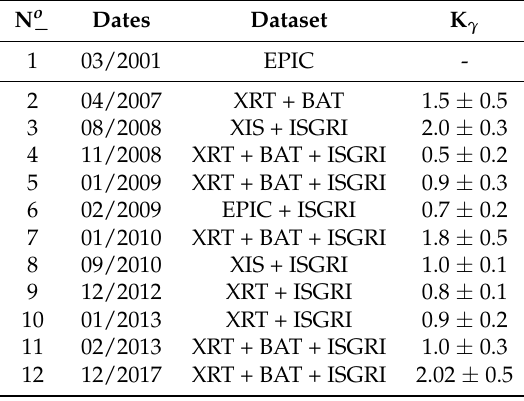
Table A5. Datasets and intercalibration constants.